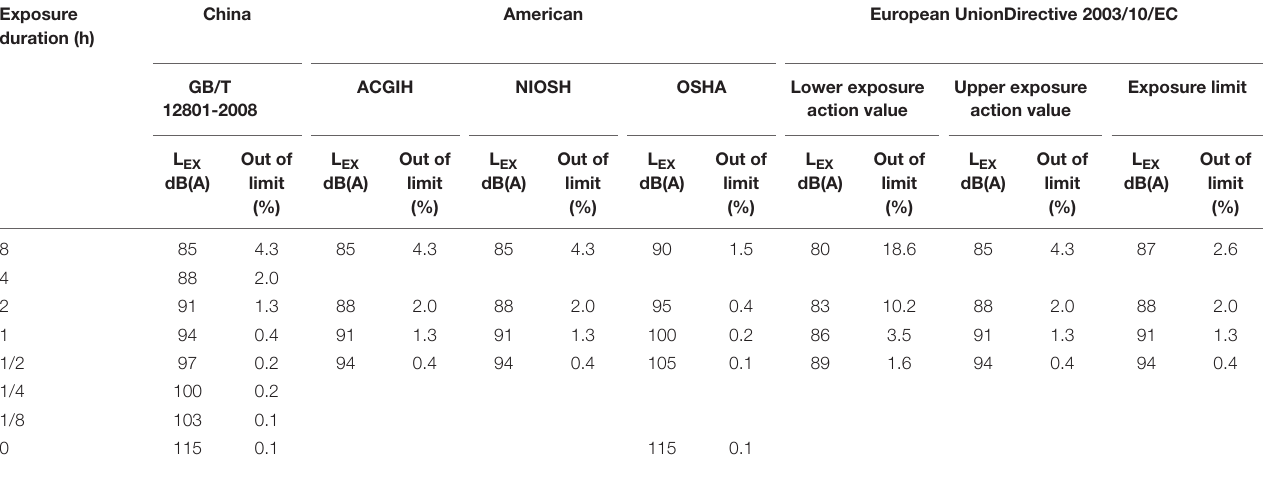
TABLE 3 | Occupational noise exposure limit and the proportion of over-limit samples ( N = 4539). Exposure duration (h)